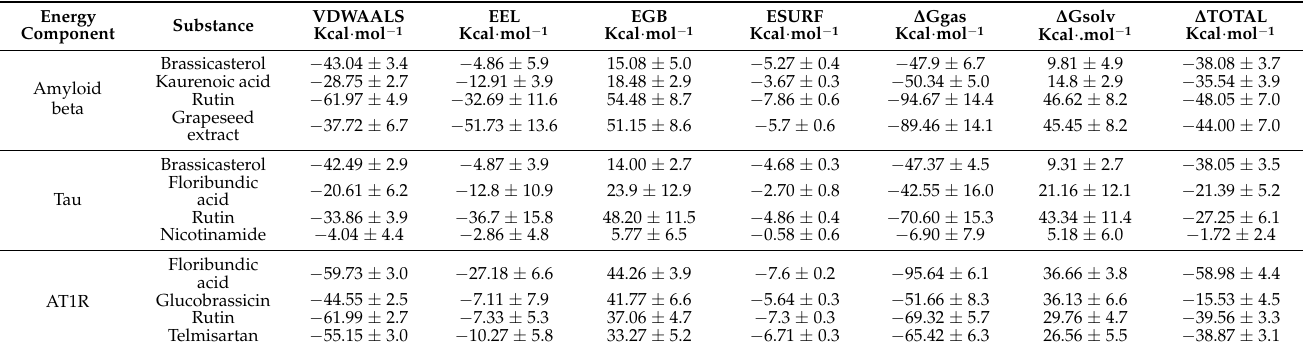
Table 3. Binding free energies estimation for the docked compounds into amyloid beta, tau, and AT1R. Energy